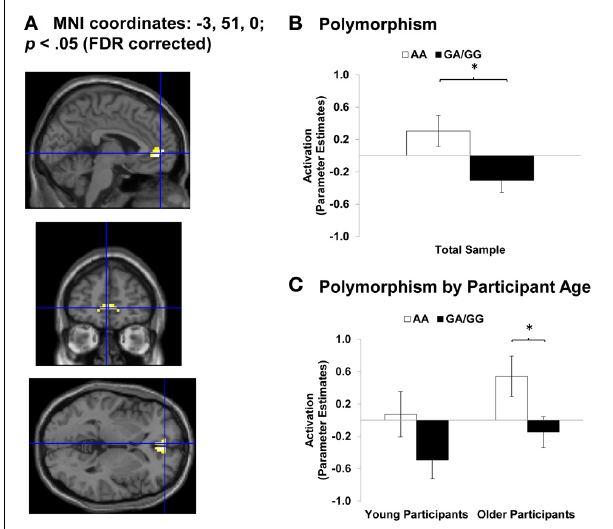
FIGURE 4 | Area of Anterior Cingulate Cortex (ACC) showing Happy Faces > Angry Faces (T-contrast). (A) Left ACC (BA 32, 10; MNI: x = − 3, y = 51, z = 0; cluster size: 26 voxels; maximum T -value for cluster: 4.19). The region of activation represents the T-map of the contrast; it is displayed on the standard reference brain in SPM. The crosshair indicates the peak voxel (local maximum) within the region of activation. (B) Bar graphs show the mean left ACC parameter estimates (beta values) separately for OXTR rs237887 AA and GA/GG carriers. (C) Bar graphs show the mean left ACC parameter estimates (beta values) separately for OXTR rs237887 AA and GA/GG carriers and young and older participants, respectively; betas depicted were extracted for each individual from a 5-mm sphere around the local maximum within the region of activation and averaged to produce a single value for each condition of interest, respectively. Note. ∗ p < 0 . 05. Error bars represent standard errors of the between-group